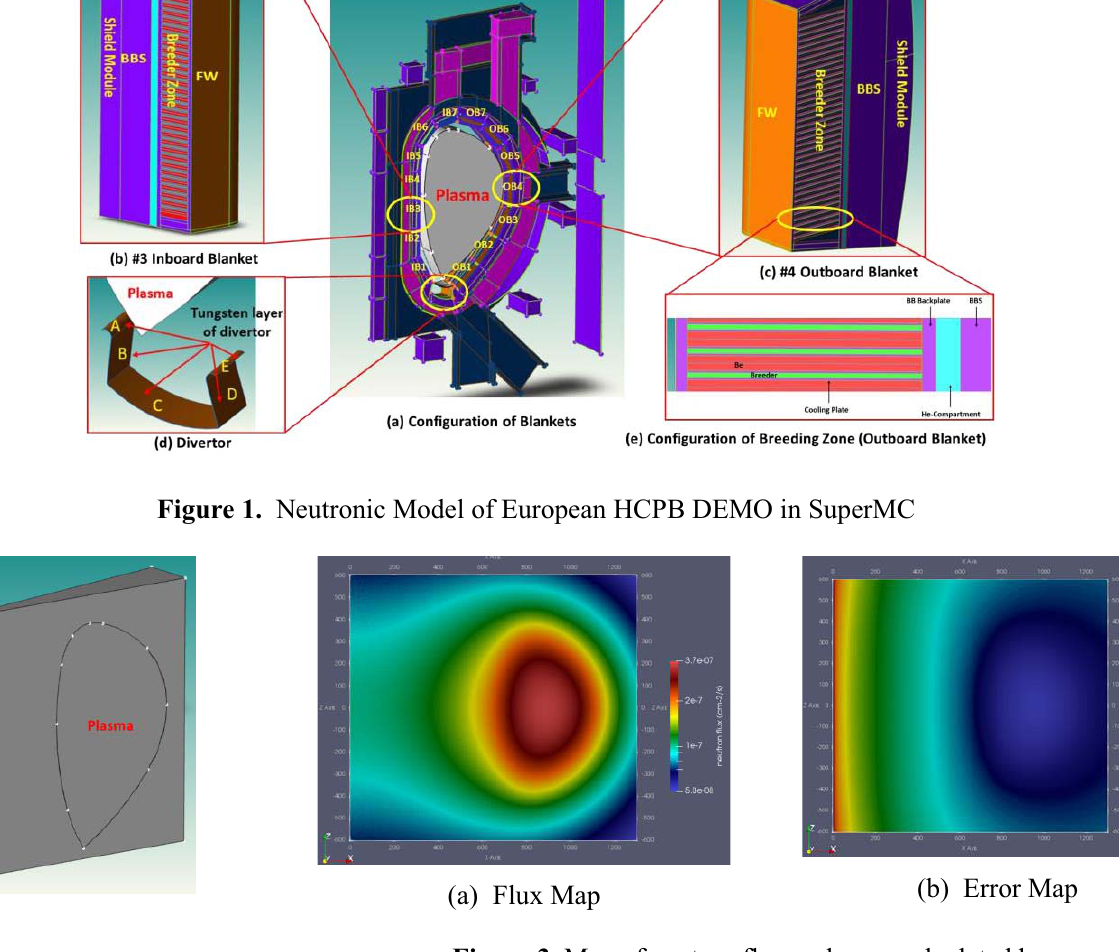
Figure 2. Neutronics model for validating European DEMO source